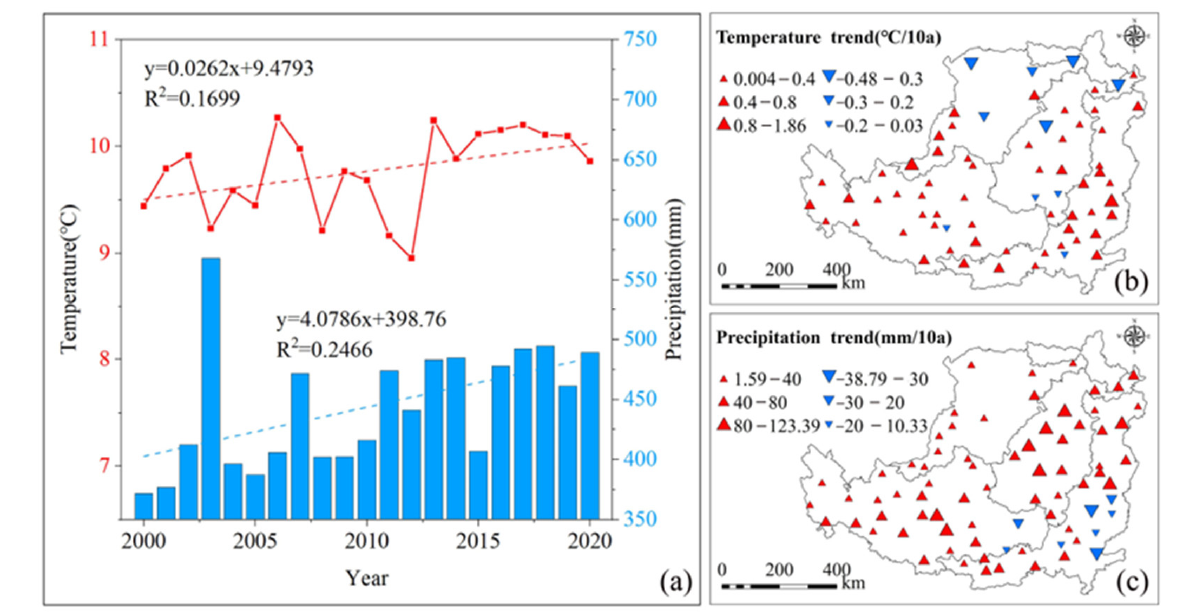
Figure 6. Characteristics of climate change on the LP from 2000 to 2020: ( a ) changes in average annual temperature and precipitation; ( b ) spatial variations in temperature; ( c ) spatial variation in precipitation.